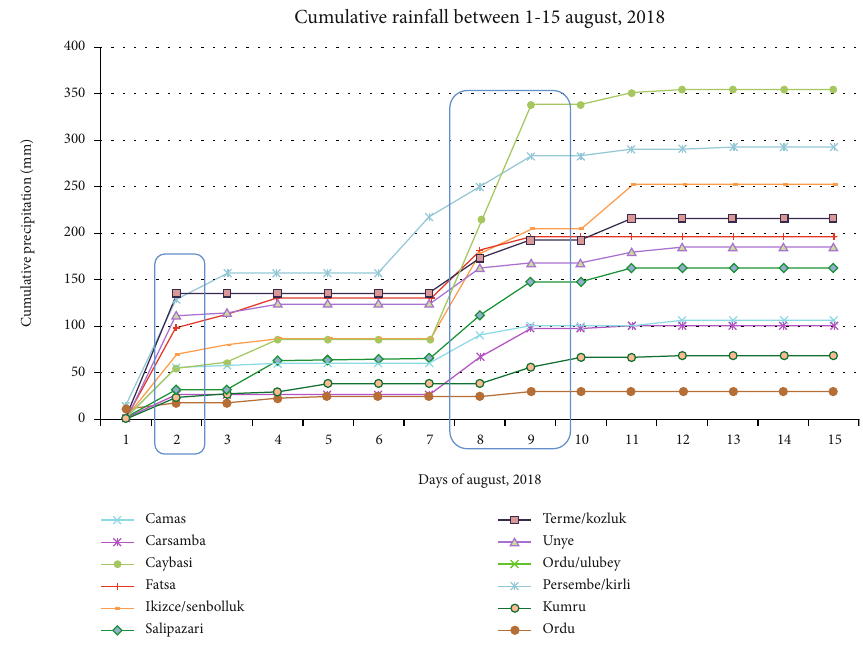
Figure 7: Cumulative rainfall in selected stations between 1 and 15 August 2018.